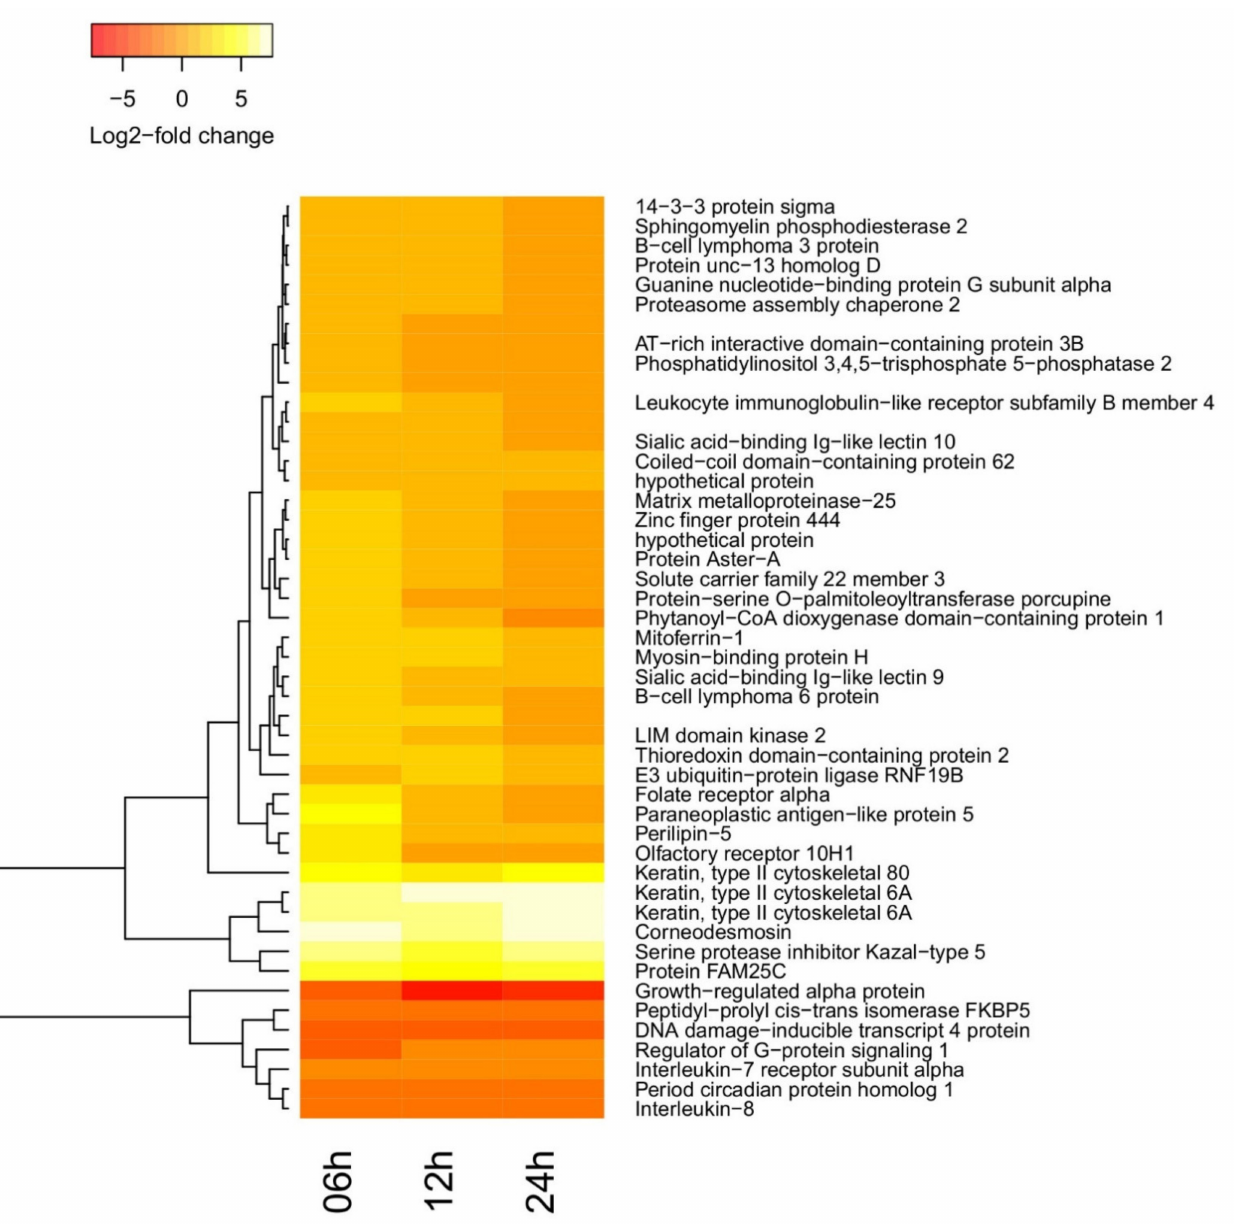
Figure 3. Heatmap for the annotated camel genes. Statistically significant differential regulation of genes at one or more time points post-vaccination. The full list of changes with corresponding statistical estimators can be found in Table